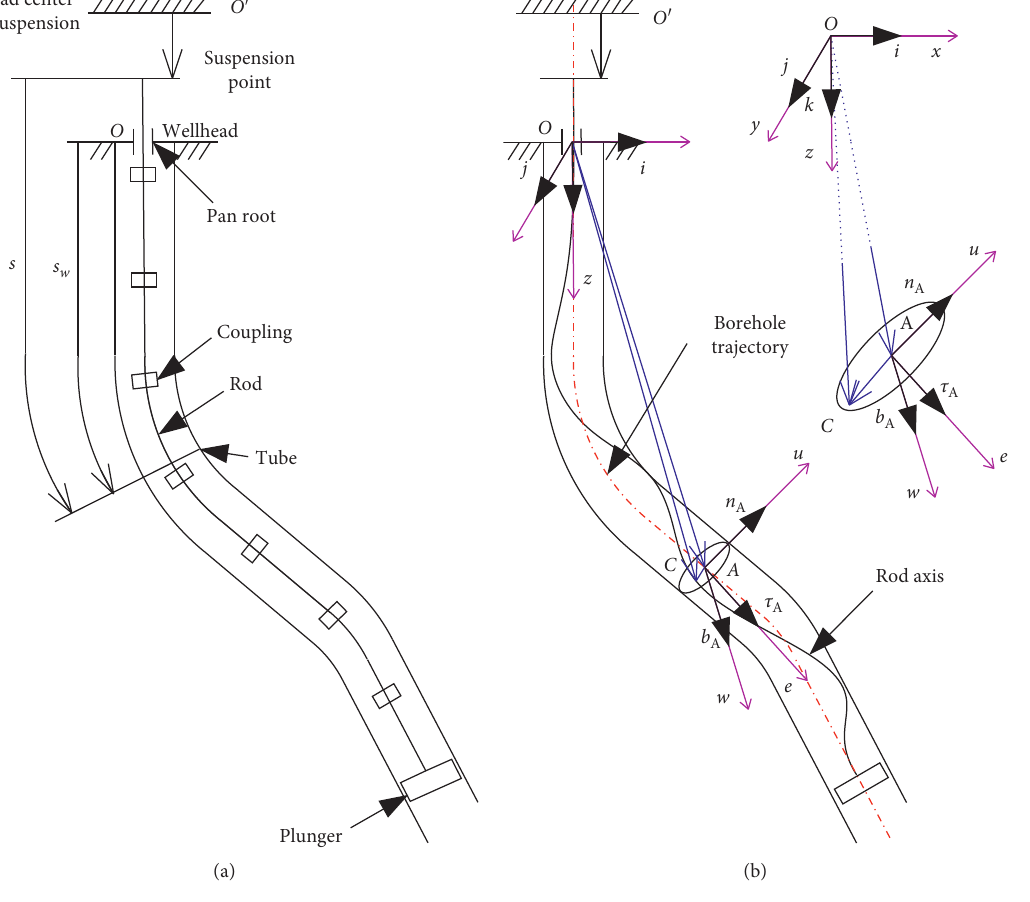
Figure 1: Models for describing borehole trajectory and SRS spatial